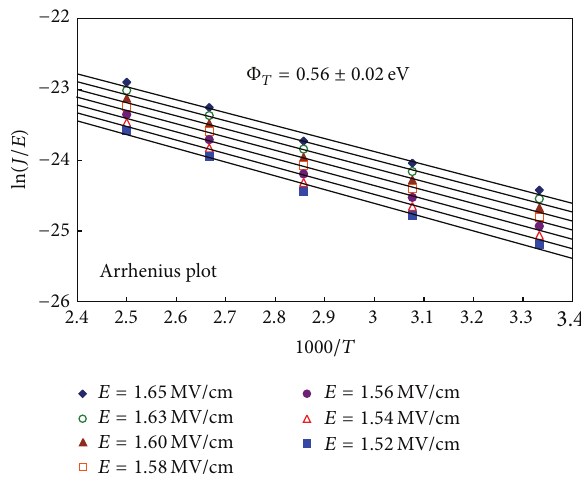
Figure 13: Arrhenius plot of the P-F emission for the laminated Pr 2 O 3 /SiON MIS capacitors at high